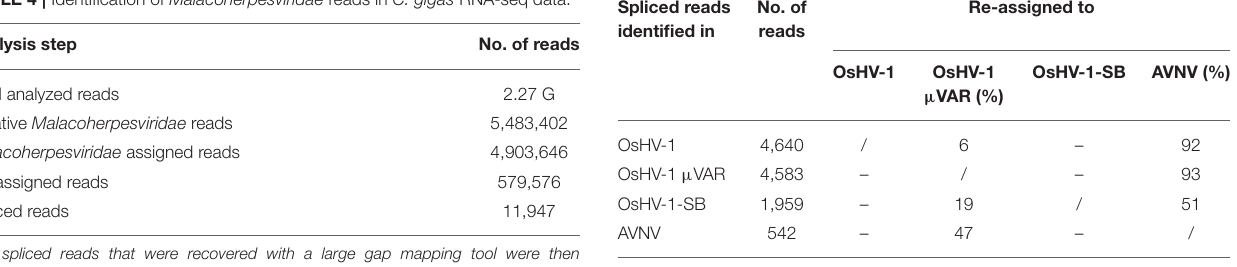
TABLE 5 | Detailed analysis of three RNA-seq samples rich in viral reads.